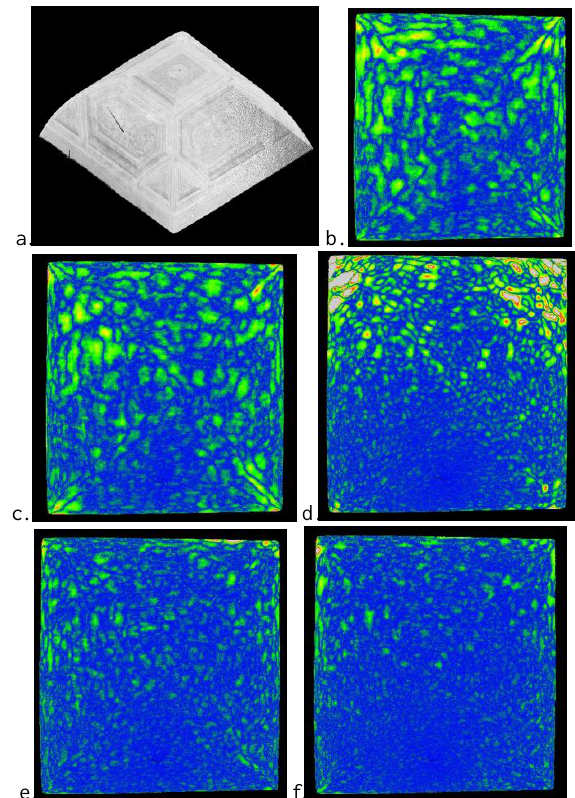
Figure 13. Results for a historic pavilion vault: (a) provides a visualization of the original point cloud; (b) comparison results result with 1 layers 50 neurons; (c) comparison results result with 1 layers 100 neurons; (d) comparison results result with 1 layers 1000 neurons; (e) comparison results result with 3 layers 20 neurons each; and (f) comparison results result with 3 layers 30 neurons